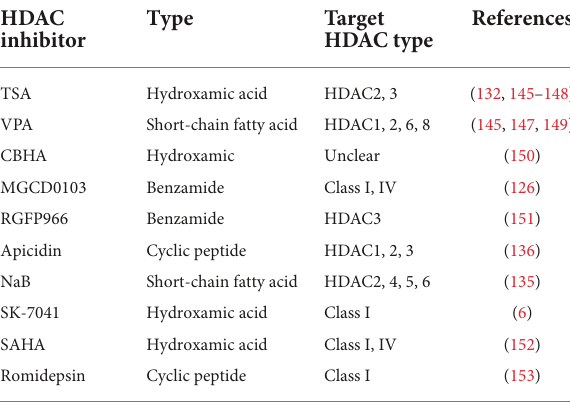
TABLE 2 Main HDAC inhibitors which have beneficial effect against cardiac